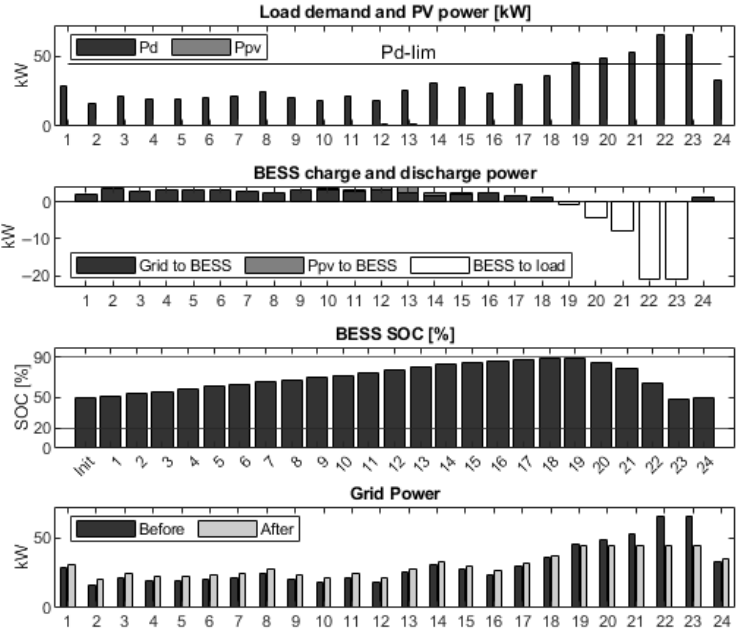
Figure 8. Load demand and PV profile, charge and discharge behavior of the BESS as well as SOC during a day, and a power profile comparison before and after peak shaving operation (the 19th of